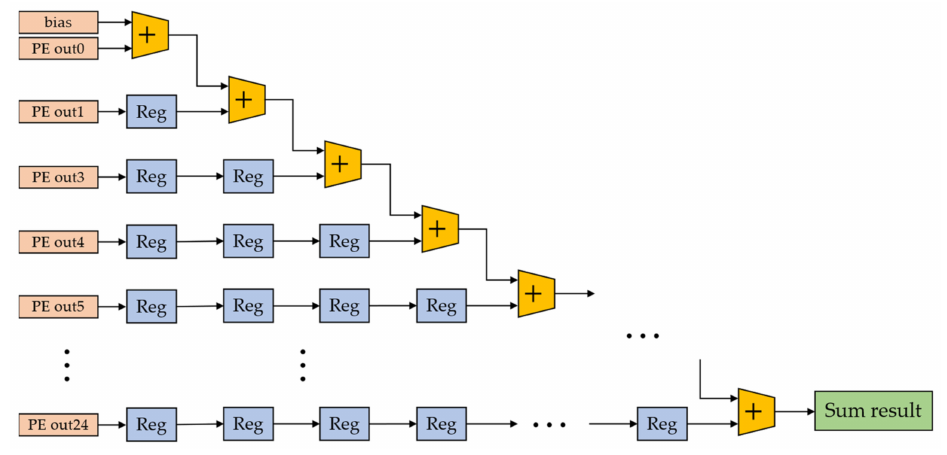
Figure 8. The designed